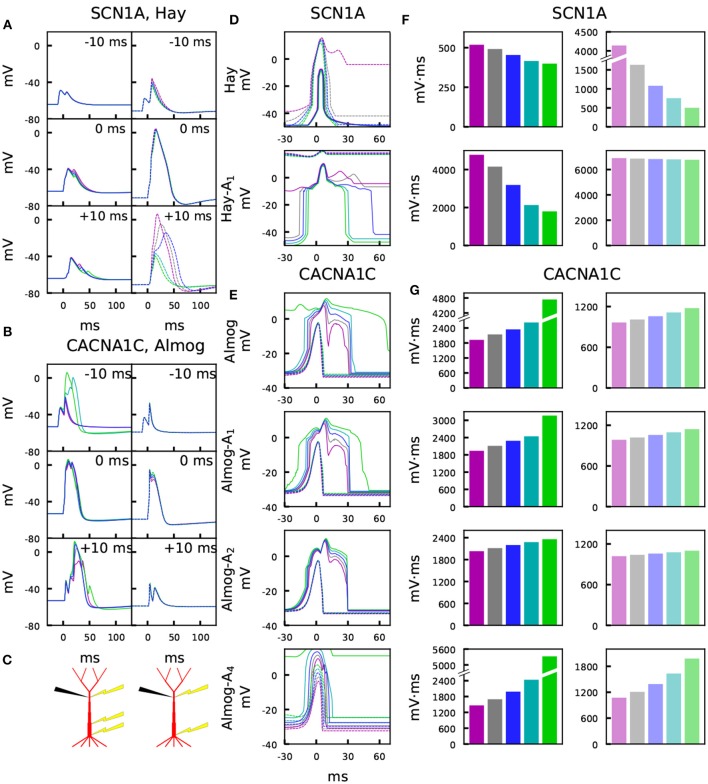
Variants affect the sensitivity to paired somatic and apical stimuli during up and down states. (A,B) Membrane potential time courses at the apical dendrite 700 μm from the soma in Hay (A) and Almog (B) models. Solid curves (left) represent the up-state responses, and the dashed curves (right) represent the down-state responses. The somatic 5-ms stimulation is activated at t = 0 ms, while the apical EPSP-like current is activated at –10 ms (top), 0 ms (middle), or +10 ms (bottom). Blue: control, other colors: different scalings of the SCN1A
(A) or CACNA1C
(B) variants of Figure 2. (C) Schematic illustration of the recording (black) and stimulation (yellow) protocols in the up-state (left) and down-state (right) paradigms. (D,E) Up- and down-state temporal windows representing the sensitivity of the Hay (C) and Almog (D) model neurons to a combination of somatic (onset at 0 ms) and apical (onset at the value of the x-axis) stimuli. Blue: control neuron, other colors: different scalings of the SCN1A
(C) or CACNA1C
(D) variants of Figure 2. The x-axis shows the inter-stimulus interval (ISI), and the y-axis shows the maximum (across time) membrane potential at the apical dendrite 700 μm from the soma. Solid curves represent the up-state responses, and the dashed curves represent the down-state responses. (F,G) Integrals of the up- (left panels, strong colors) and down-state (right panels, dim colors) temporal windows of panels (C) and (D) across the shown ISIs (–30 to 70 ms) for the SCN1A variant according to the Hay models (F) and for the CACNA1C variant according to the Almog models. In the calculation of the integrals, the baseline amplitude –50 mV (F) or –40 mV (G) was subtracted from the data.